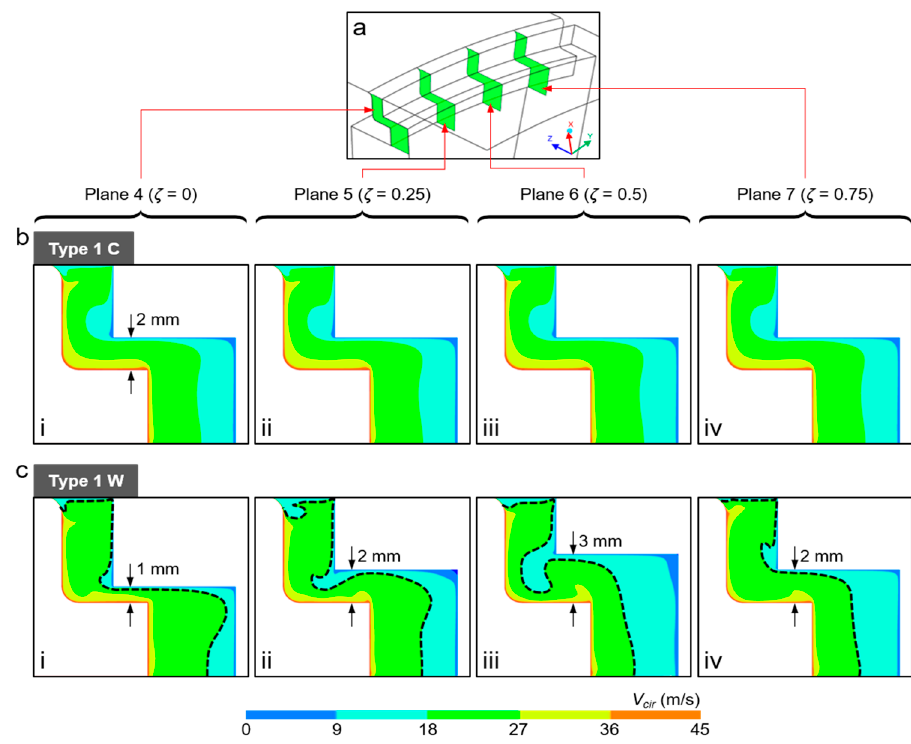
Figure 7. Circumferential velocity contour in wheelspace of Type 1. ( a ) Locations of Planes 4, 5, 6, and 7. ( b ) Circumferential velocity contour in wheelspace of Type 1 C in ( i ) Plane 4, ( ii ) Plane 5, ( iii ) Plane 6 and ( iv ) Plane 7. ( c ) Circumferential velocity contour in the wheelspace of Type 1 W in ( i ) Plane 4, ( ii ) Plane 5, ( iii ) Plane 6 and ( iv ) Plane 7.